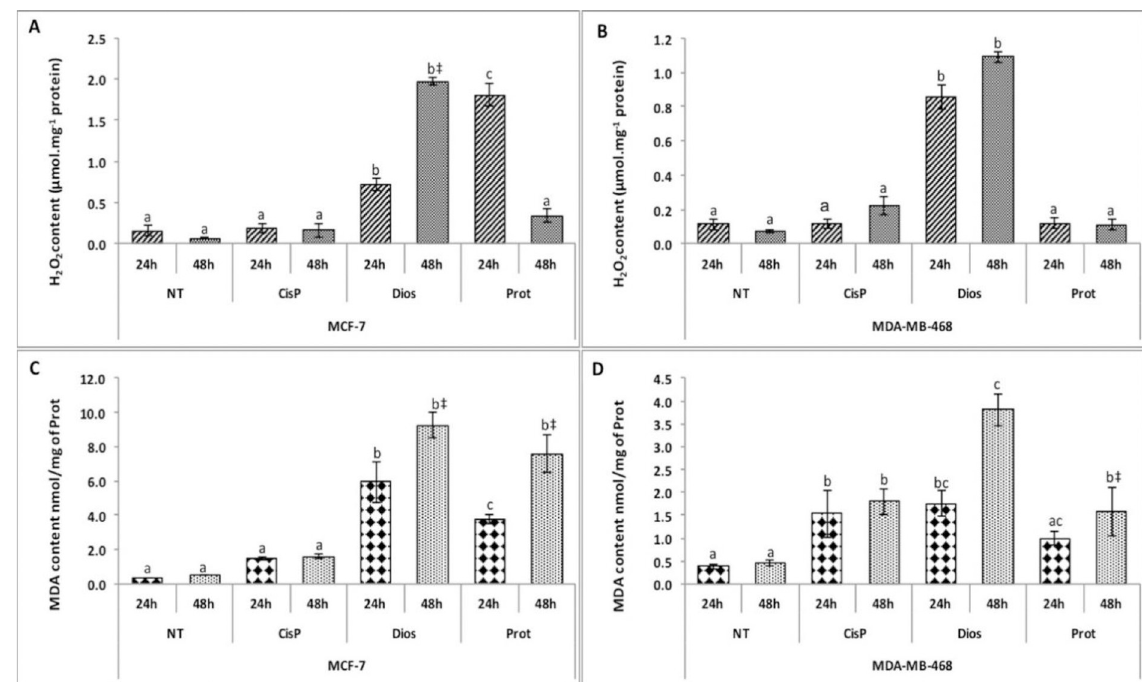
Fig 3. Protodioscin and dioscin increase ROS generation in the adenocarcinoma MCF-7 and MDA-MB-468 cell lines. ( A/B ) hydrogen peroxide (H 2 O 2 ) content; ( C/D ) malondialdehyde (MDA) concentration. NT (not treated cells) and CisP (Positive control). Data are represented as the mean of six replicates issued from two independent experiments. Bars represent the standard error. Different letters indicate significant differences among treatments in the same tumor line at p < 0.05. The signs � , †, and ‡ indicate a significant difference between the time treatment at p < 0.05, p < 0.01, and p < 0.0001, respectively.